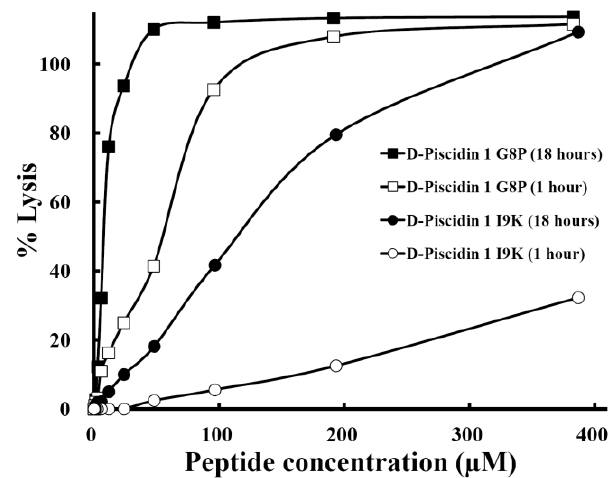
Figure 8. The comparison of hemolytic activity of peptide D -piscidin 1 G8P and D -piscidin 1 I9K after 1 hour or 18 hour treatment. The concentration-response curves of peptides for percentage lysis of human red blood cells (hRBC) are shown. The control for 100% hemolysis was a sample of erythrocytes treated with 0.1% Triton-X 100. The peptide concentration is in